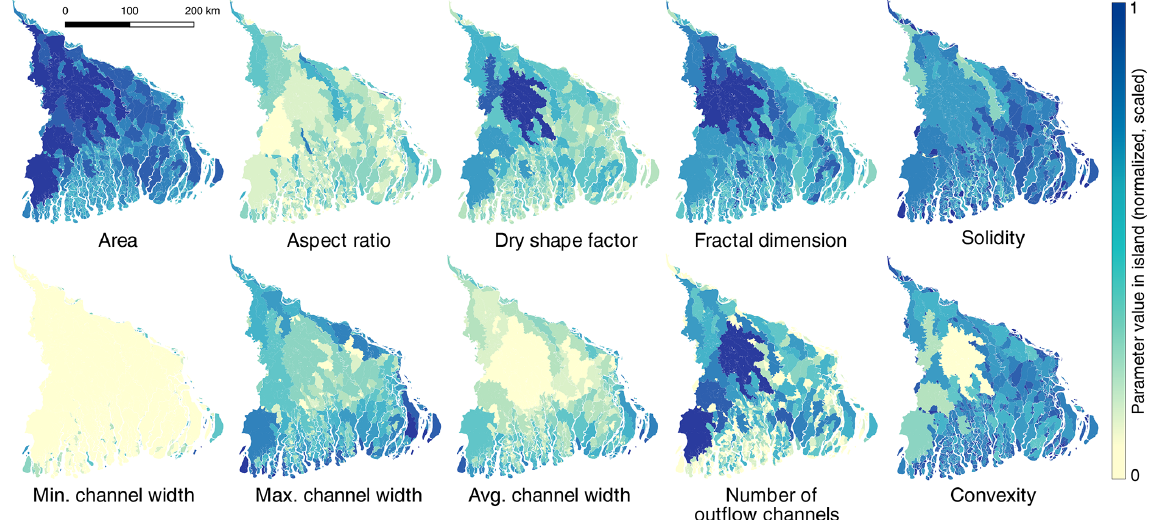
Figure 3. Map view of metrics after they have been normalized and scaled. Each metric is normalized using a logarithmic normalization and is shown scaled between 0 and